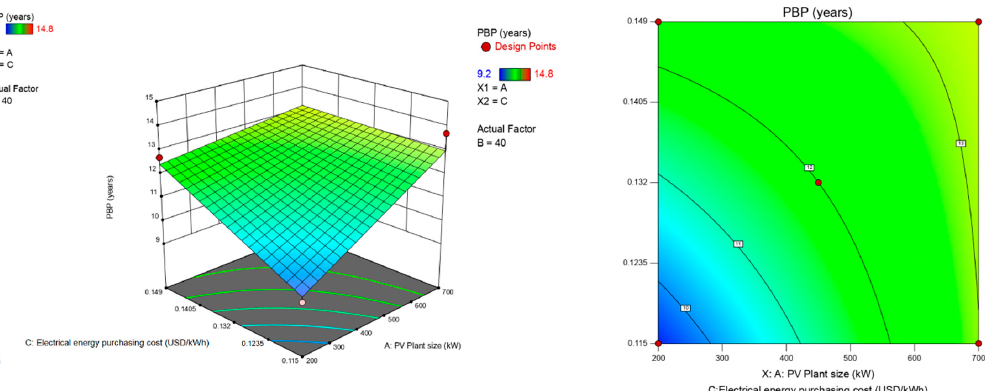
Figure 8. Response surface and contour plots for PV plant size and electrical energy purchasing cost on the PBP at a reduction in PEM capital cost of ( a ) 0%, ( b ) 20%, and ( c ) 40%.